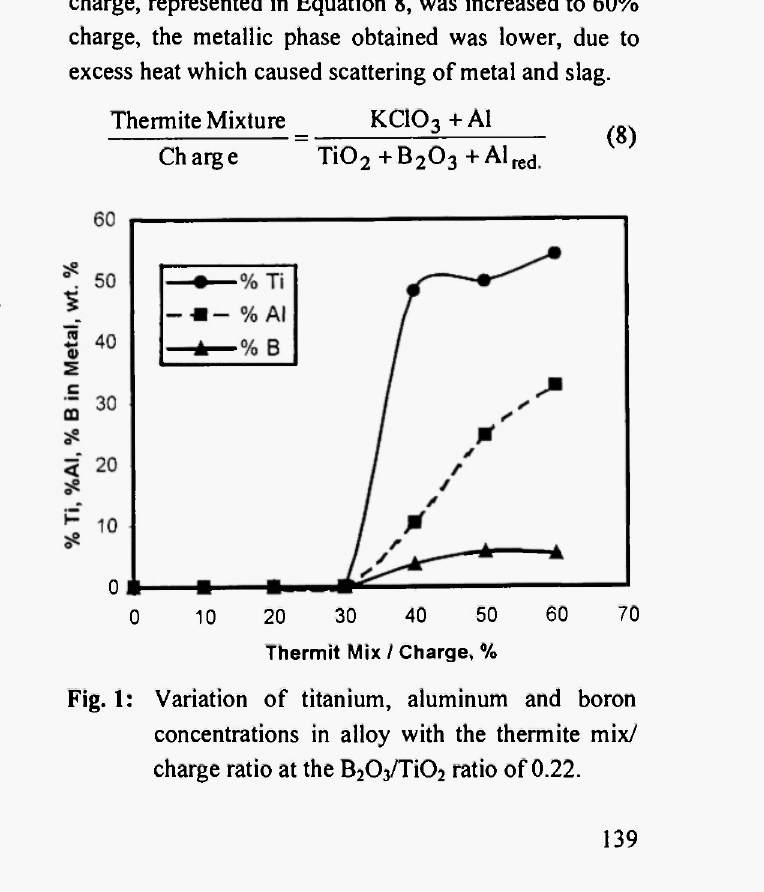
Fig. 1: Variation of titanium, aluminum and boron concentrations in alloy with the thermite mix/ charge ratio at the B 2 0 3 /Ti0 2 ratio of